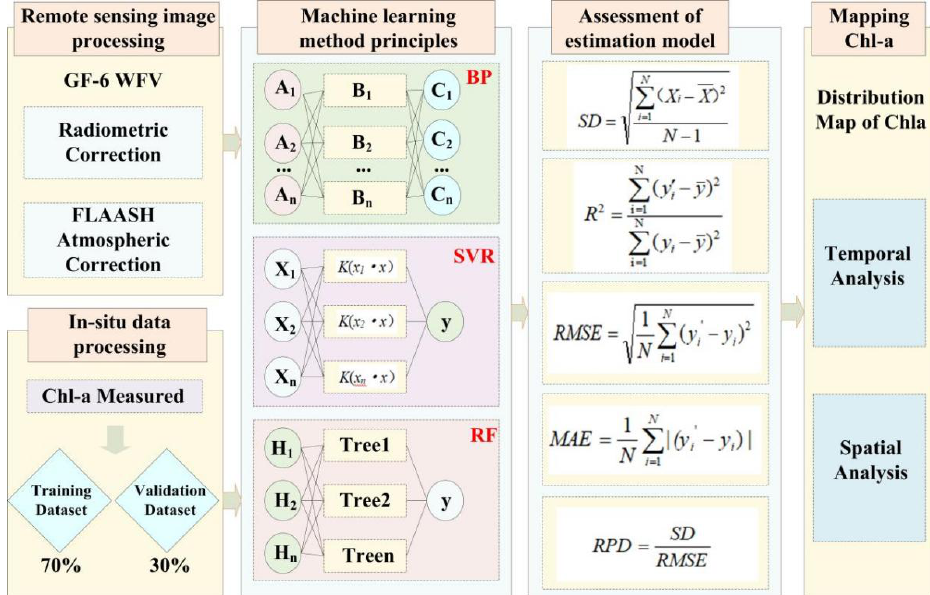
Figure 2. Technology